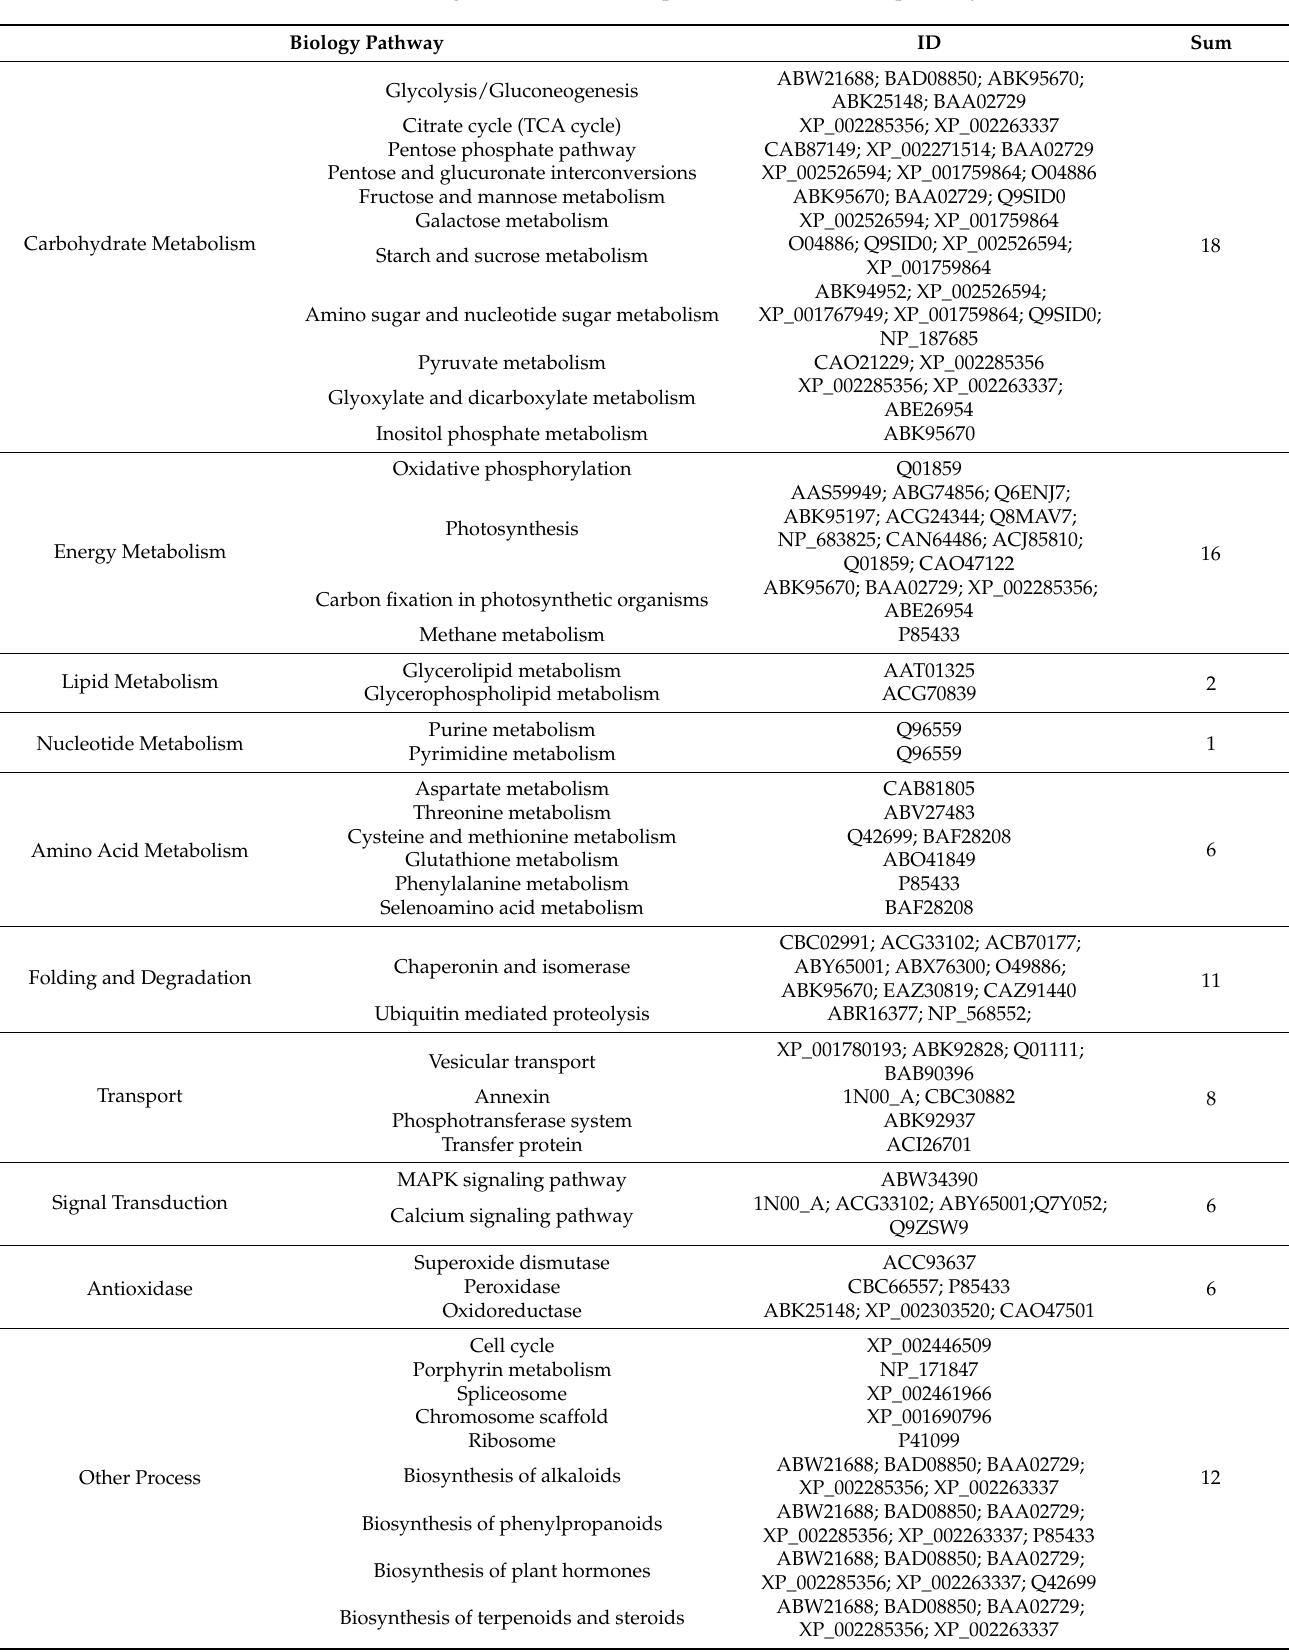
Table 4. Categories of all different proteins based on their